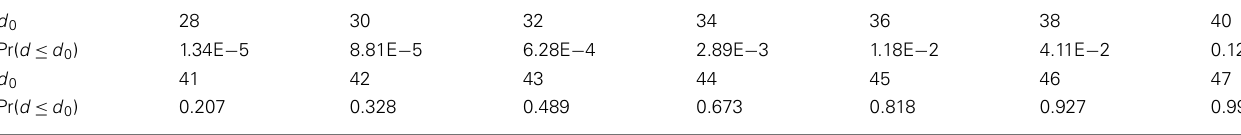
Table 4 | d -Value cdf for cancer cells in a clinically detectable tumor.